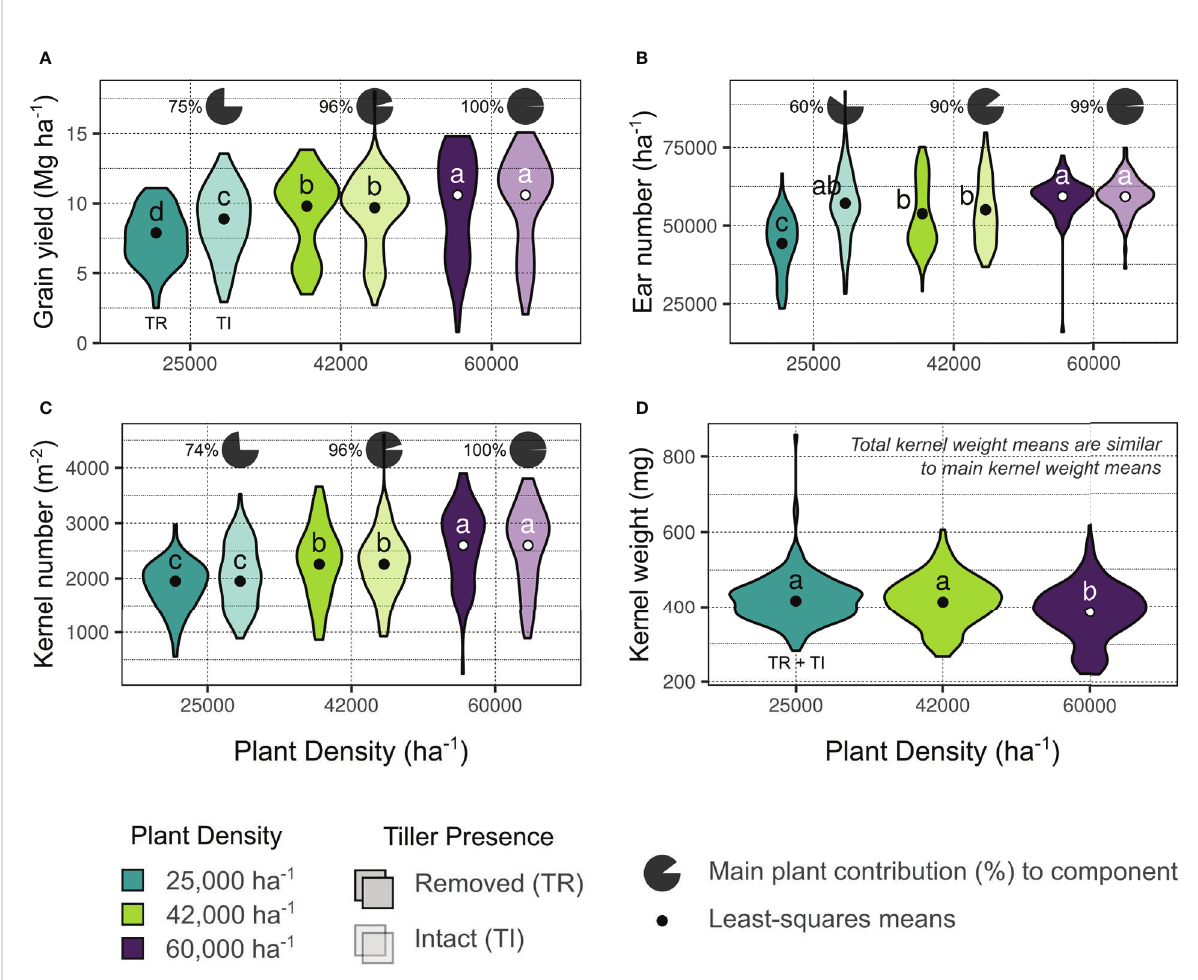
FIGURE 2 Summary of comprehensive yield (A) , and yield components ( (B) , ear number; (C) , kernel number; (D) , kernel weight) based on treatment factors deemed signi fi cant by analysis of variance (Supplementary Tables 2-4). Colors indicate plant density (blue – 25000 plants ha -1 , green –